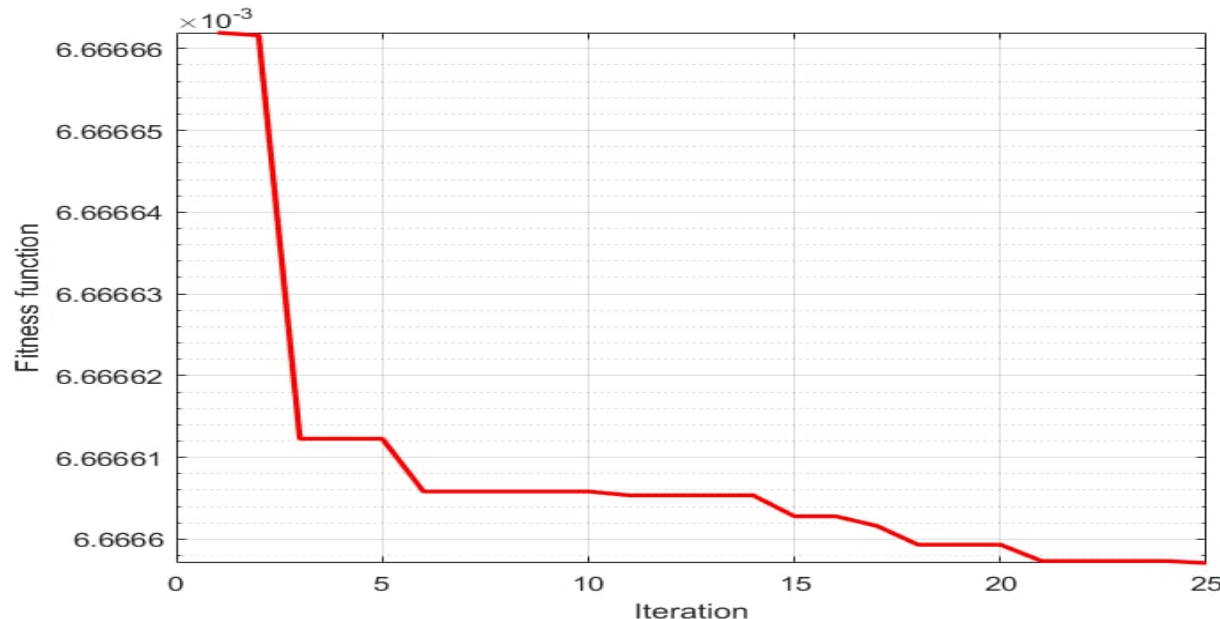
Figure 9. The convergence of GWO.